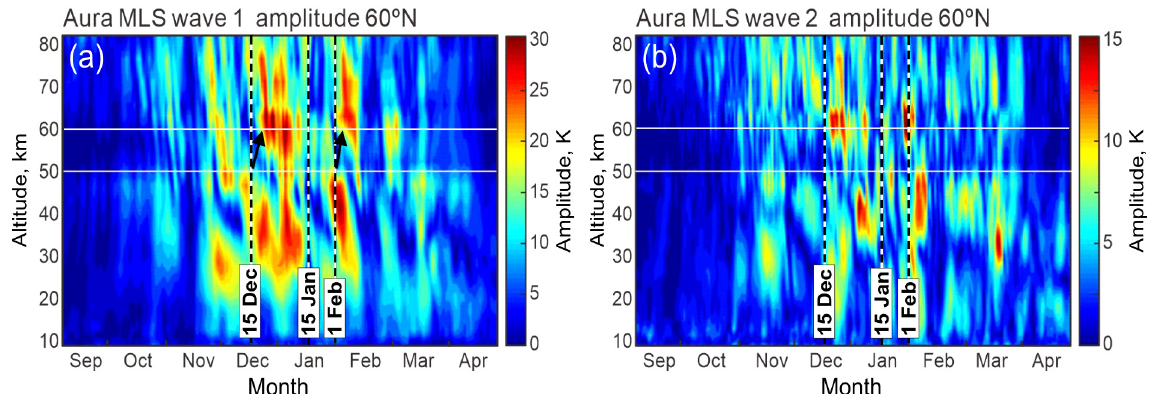
Figure 5. Time–altitude section of amplitude of ( a ) wave 1 and ( b ) wave 2 at 60 ° N from the MLS temperature data. The time interval September 2019–April 2020 is presented. Arrows indicate cases of rapid vertical amplification of the wave 1 amplitude between 50 km and 60 km (white horizontal lines).